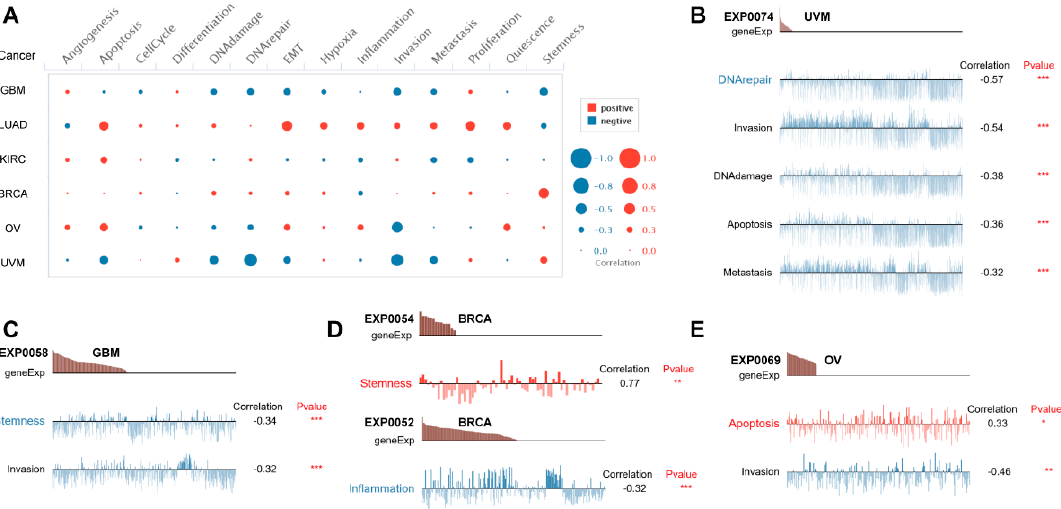
Figure 9. Single-cell functional analysis of PBX4 from the CancerSEA database. ( A ) Overview of PBX4 functional states in different human cancers. The functions were significantly correlated with PBX4 in ( B ) UVM, ( C ) GBM, ( D ) BRCA, and ( E ) OV. (* p < 0.05, ** p < 0.01, *** p < 0.001).